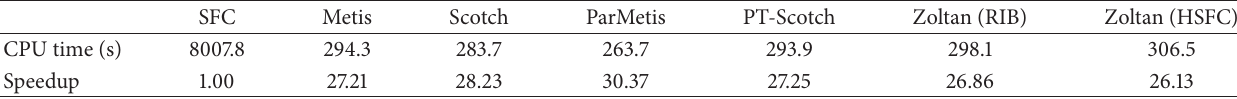
Table 1: Comparisons of CPU time and speed up on 512